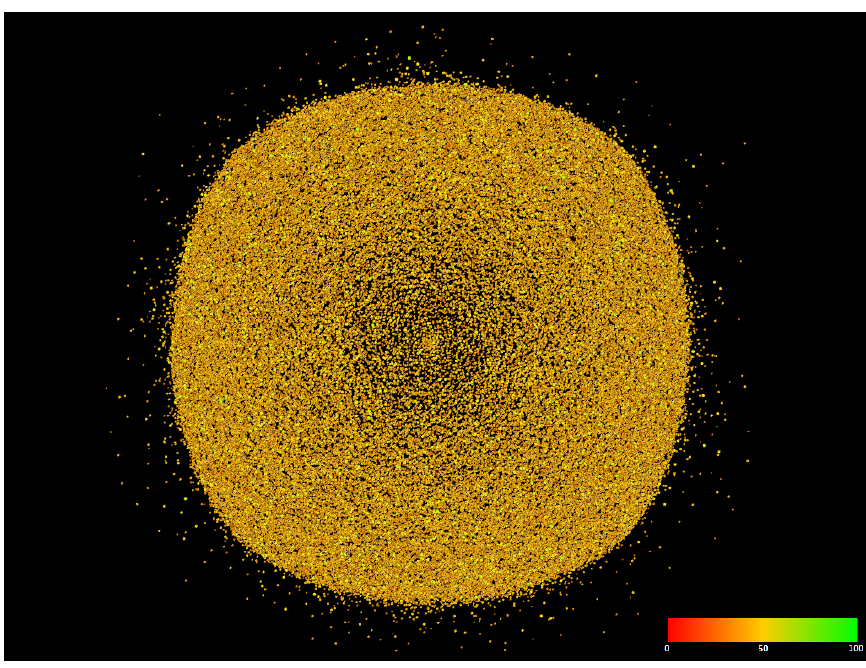
Figure 2. Idle times per router, basic model.